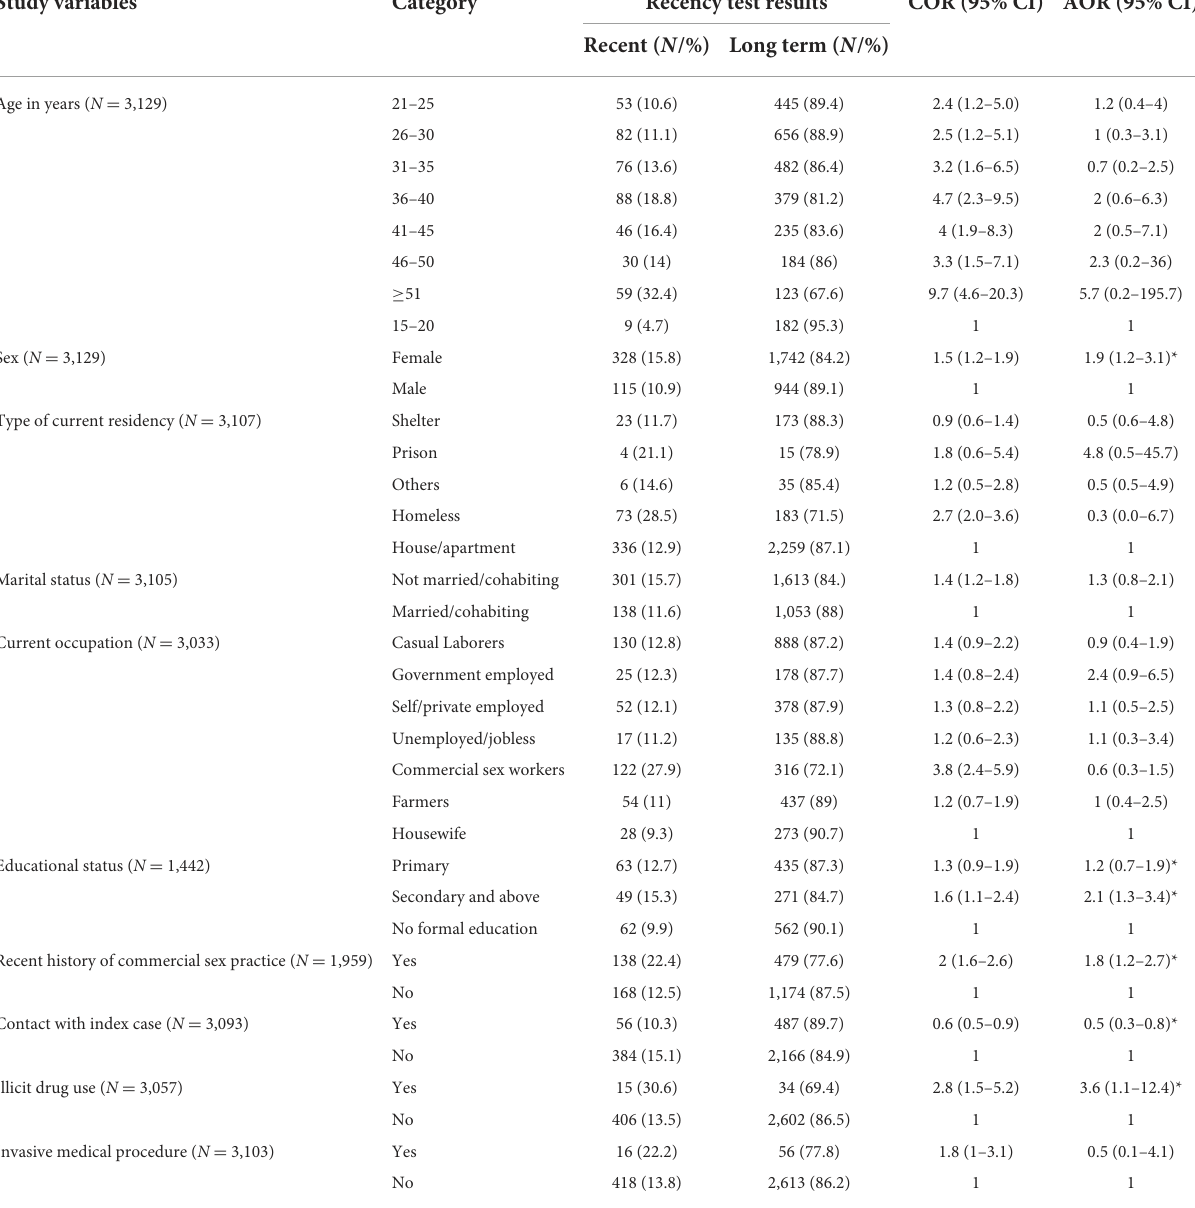
TABLE 2 Risk factors associated with recent HIV infections in the Amhara regional state, northern Ethiopia, 2021 ( N =